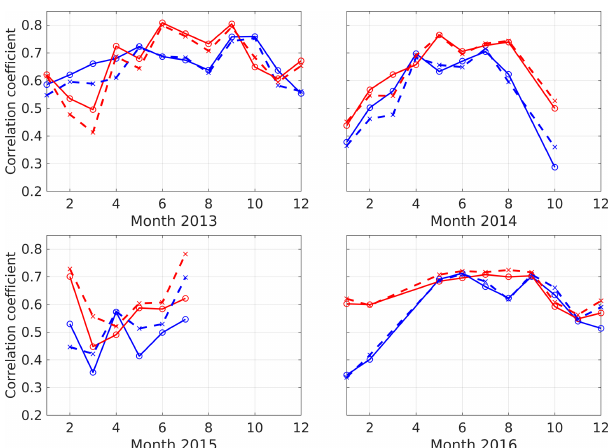
Figure 13. Correlations between estimated wet gradients from the WVR data and the GPS data from ONSA (solid lines) and ONS1 (dotted lines), averaged over 15min when the hydrostatic gradients are removed from the total GPS gradients for each month of the 4 years. The east gradients are presented with red lines and the north gradients with blue